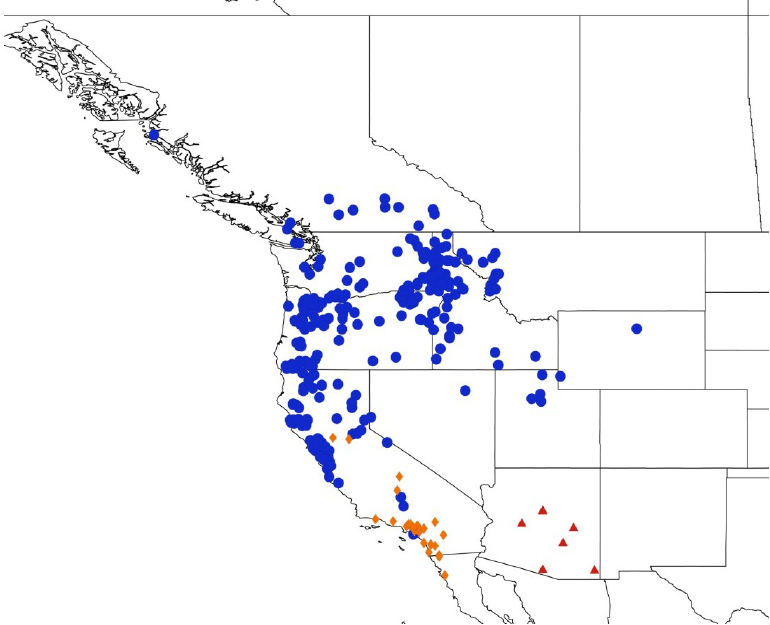
Figure 37. Distribution of Platypedia areolata (blue circles), P. aperta (orange diamonds), and P. balli (red